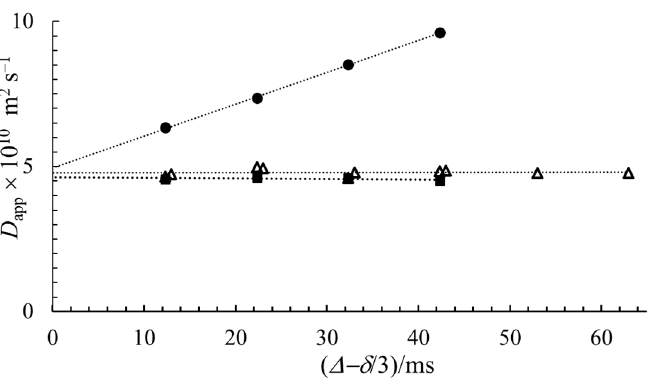
Figure 5. The apparent diffusion coefficient of NaDS as a function of diffusion time at 319 K. • normal 5 mm NMR tube, (cid:4) in a sapphire tube applying the standard pulse sequence without convection reduction and ∆ with pulse sequence with convection compensation.